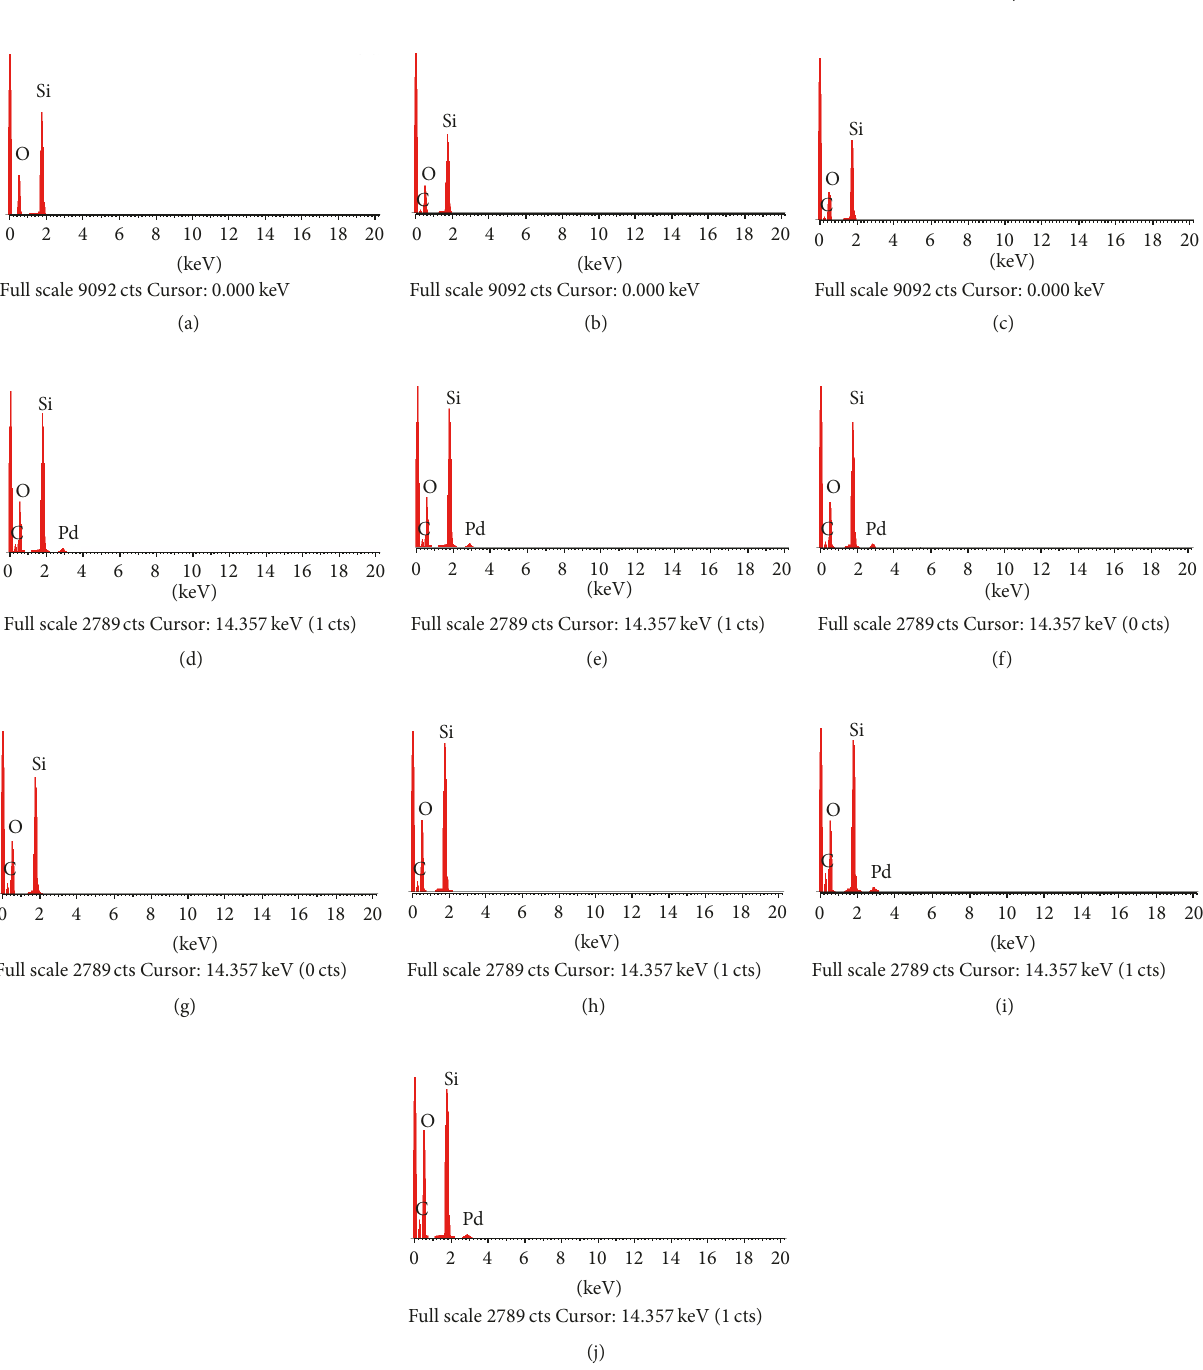
Figure 4: EDS spectrum of (a) SiO 2 , (b) SiO 2 @ imineSA, (c) SiO 2 @ imineSB, (d) SiO 2 @ imineSA-Pd-II, (e) SiO 2 @ imineSB-Pd-II, (f) SiO 2 @ imineSA-Pd-I, (g) SiO 2 @ imineNA, (h) SiO 2 @ imineNB, (i) SiO 2 @ imineNA-Pd-II, and (j) SiO 2 @